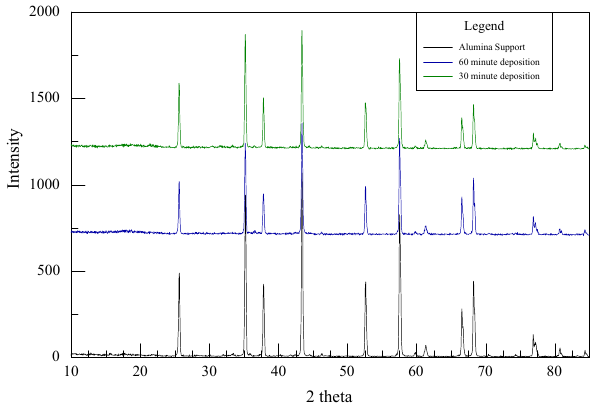
Figure 2. XRD patterns from the alumina support, 30-min and 60-min deposition.